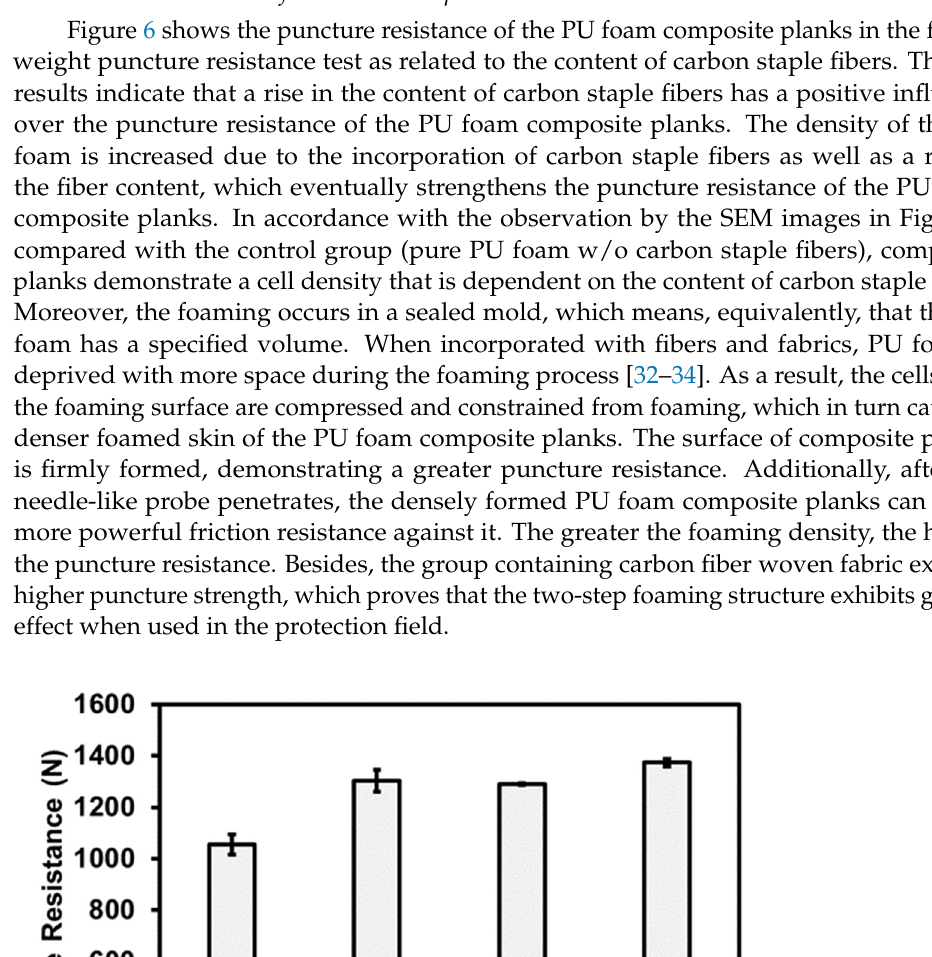
Figure 5. ( a ) SEM image and ( b ) magnified image of fractured site of composite planks after the impact test.